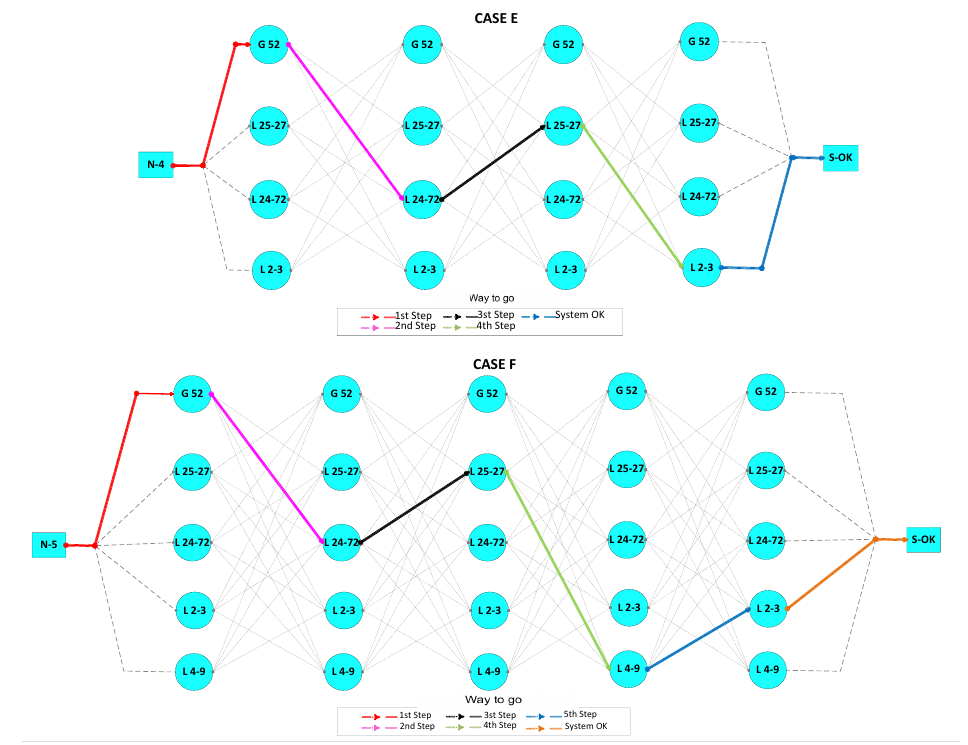
Figure 8. Decision tree for the entry of EPS elements, cases E and F.